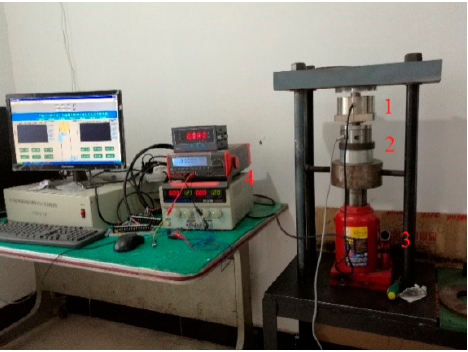
Figure 24. Experimental setup. ( 1 ) Particle damping sensor; ( 2 ) Standard sensor; ( 3 ) Hydraulic cylinder; ( 4 ) Displayers.